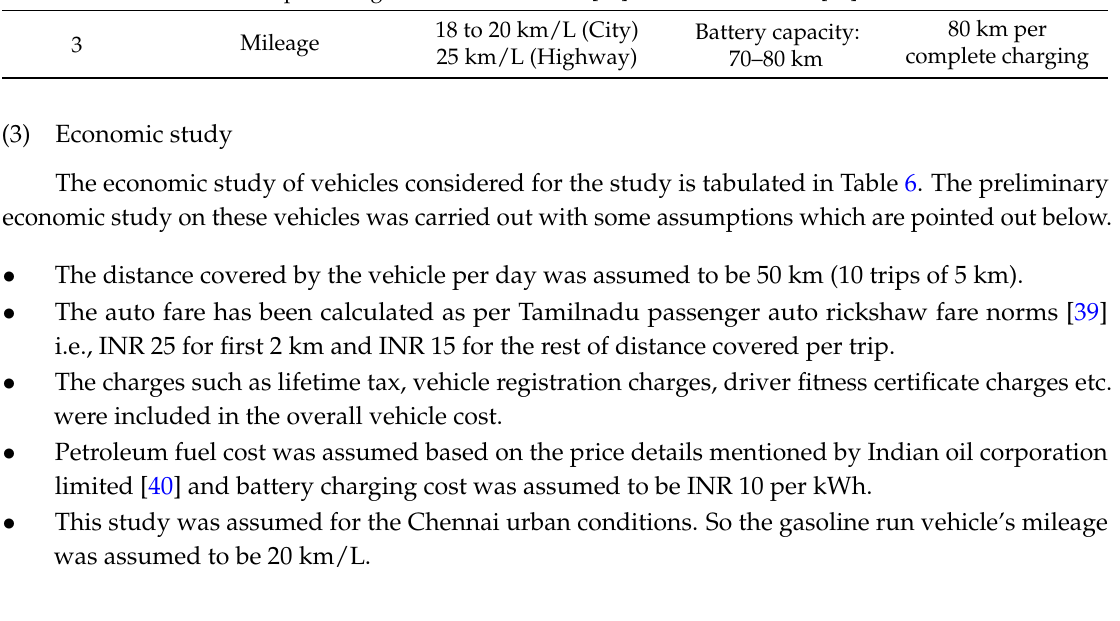
Table 6. Economic analysis the vehicles involved in the